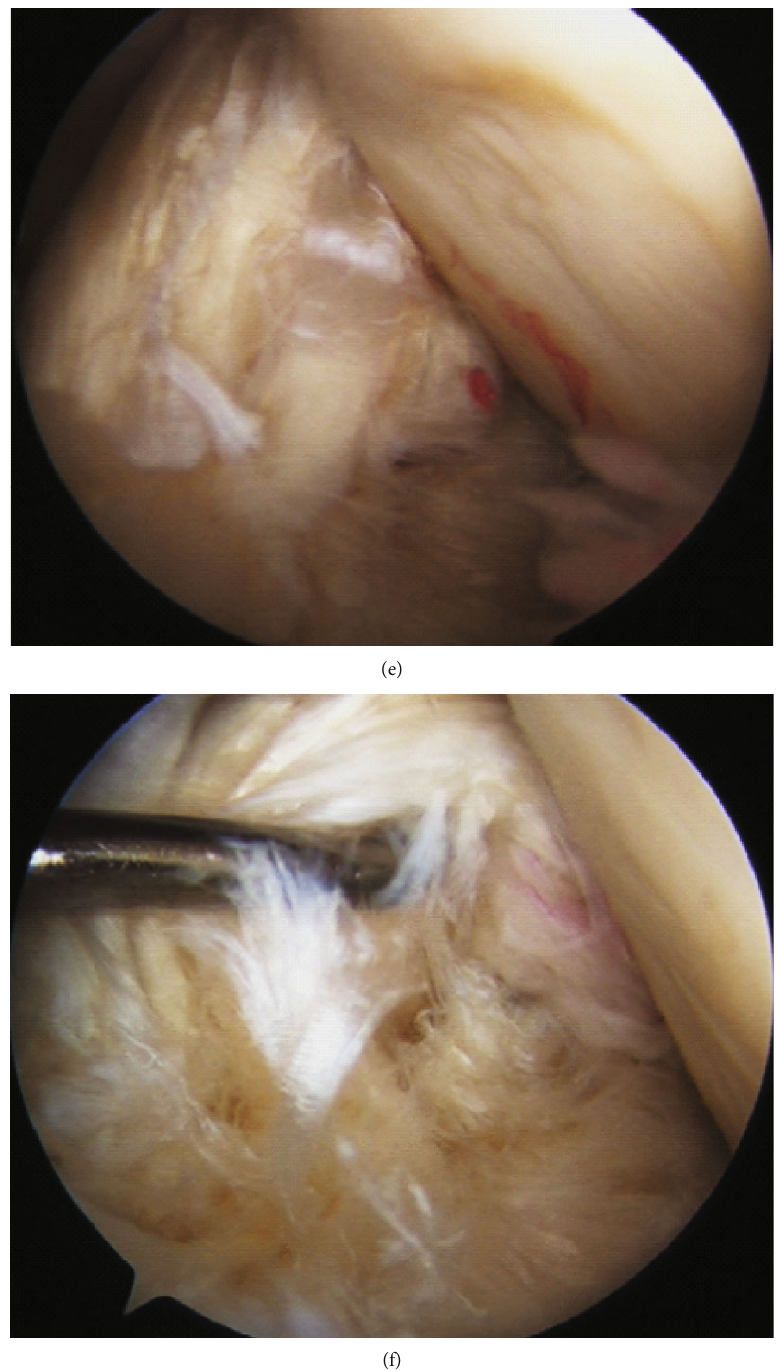
Figure 4: Arthroscopy showed (a, d) hypertrophied ACLs and the (b, d) presence of intraligamentous mucoid degeneration. (e) The posterolateral bundles in the ACLs were slightly loose at the lateral portion of the intercondylar notch. (c, e) Further, there was a partial depression of cartilage in the same